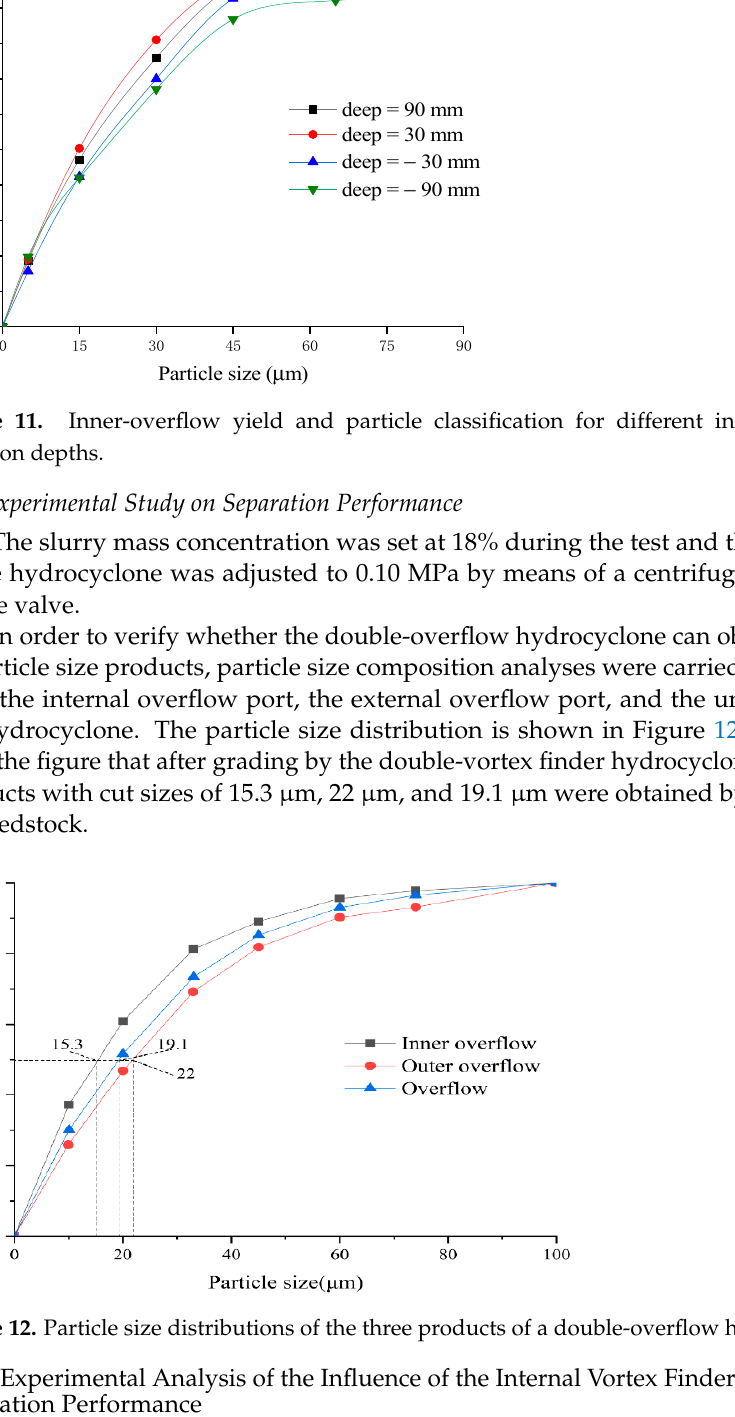
Figure 10. Internal overflow yield of different internal vortex finder insertion depths.